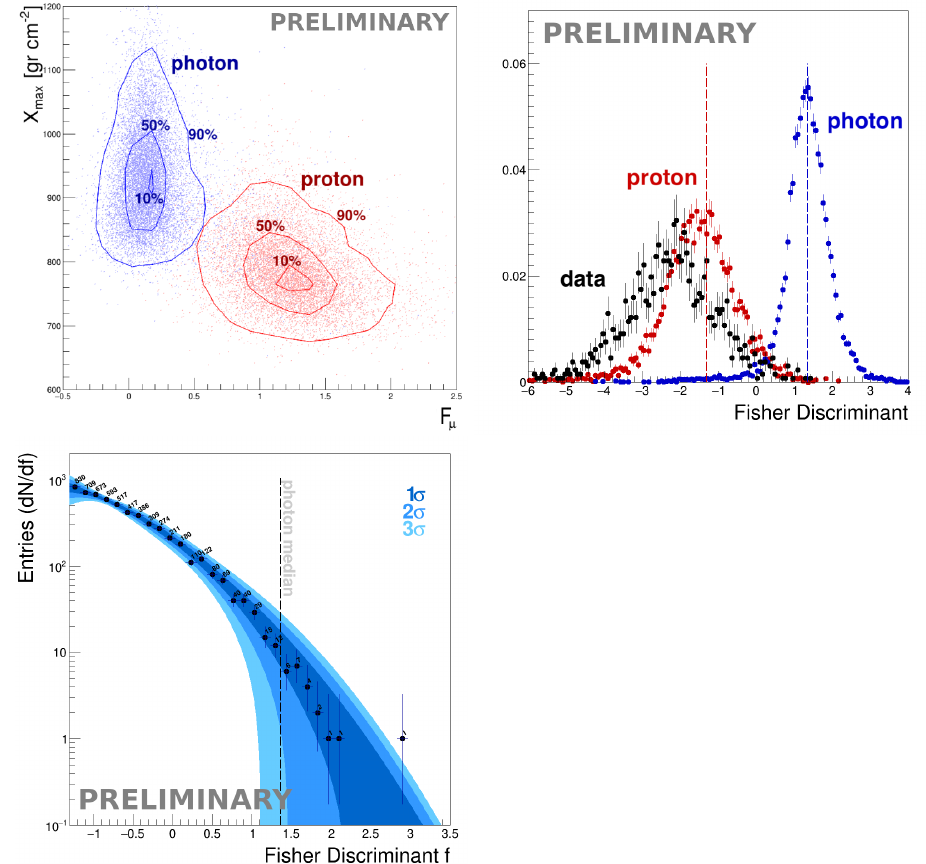
Figure 4. ( Top left ) scatter plot of X max and F µ , i.e., the observables used in the hybrid search for photons using air-shower universality, for simulated primary photons (blue) and protons (red); The contour lines enclose 90%, 50% and 10%, respectively, of the events. ( Top right ) distributions of the Fisher discriminant f for simulated primary photons (signal, blue) and protons (background, red), and for the burnt sample (black); the dashed red line marks the tail of the proton distribution; the dashed blue line indicates the median of the photon distribution. ( Bottom ) the tail of the distribution of f for the hybrid data sample (black dots); the dashed line represents the photon-candidate cut; the shaded blue regions show the 1 σ , 2 σ and 3 σ uncertainty bands for background expectation. For more details, see